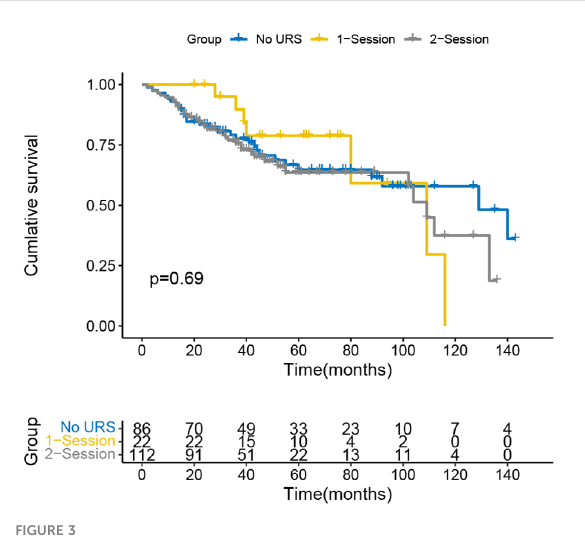
FIGURE 1 Survival analysis of intravesical recurrence in all patients.